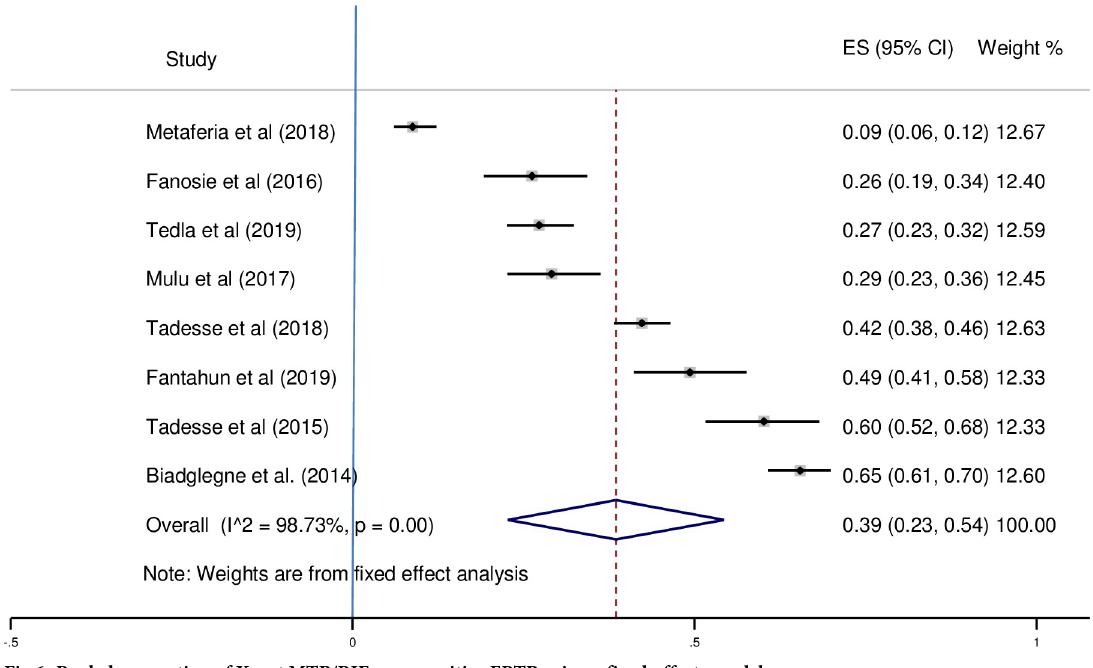
PLOS ONE | https://doi.org/10.1371/journal.pone.0276701 November23, 2022 10 /